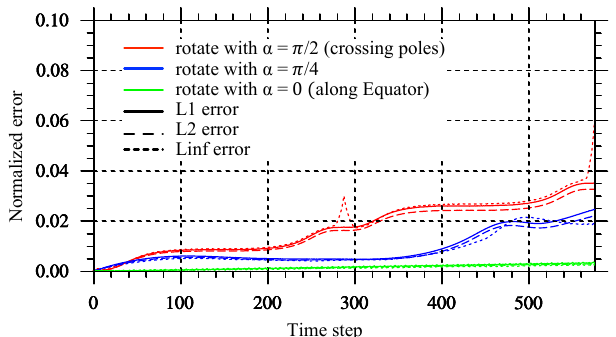
Figure 7. The normalized errors in solid rotation test case. Three runs with different rotation parameter α have different error levels. The run that rotates along the Equator has the lowest